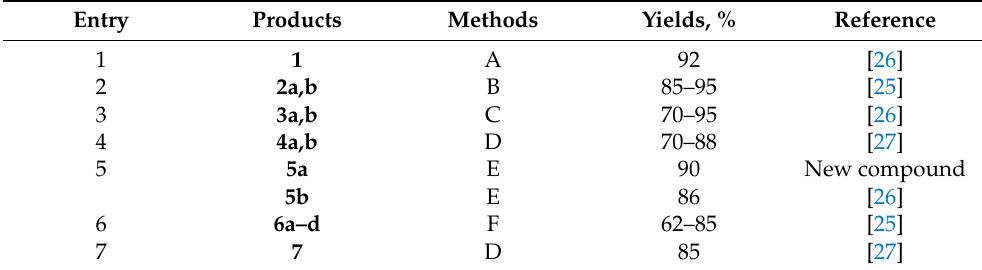
Table 1. Synthesis of 1 H -1,2,3-triazole derivatives 1 – 7 .